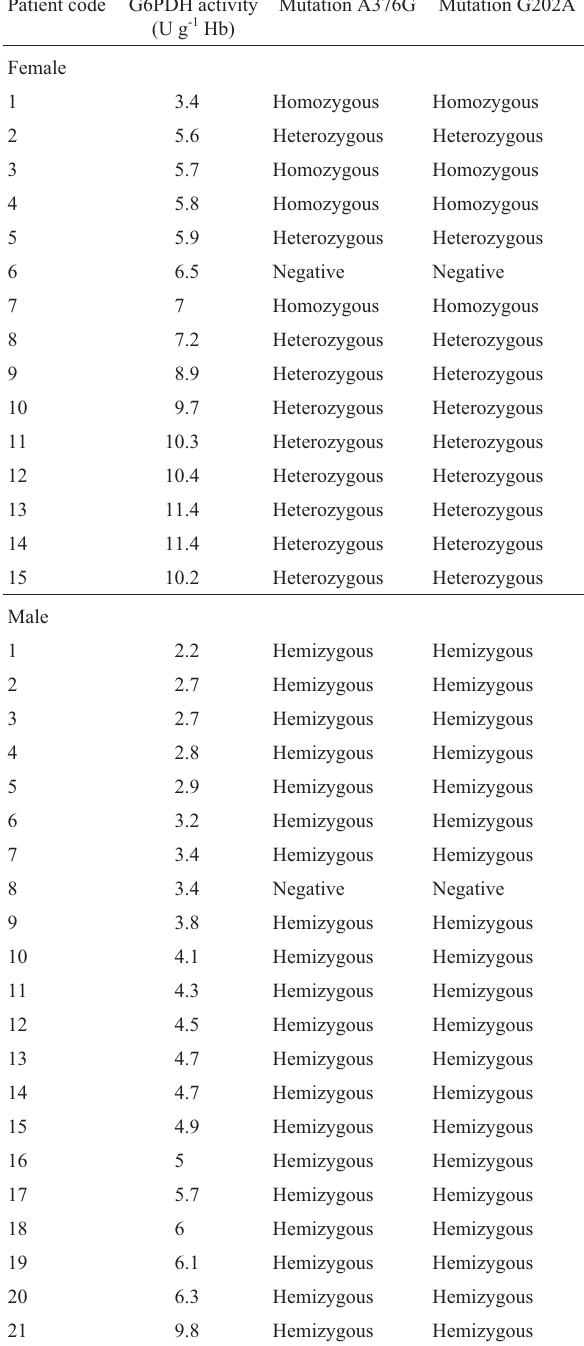
Table 1 - Glucose-6-phosphate dehydrogenase (G6PDH) activity of 15 female and 21 male (n = 36) patients from the southern Brazilian city of Porto Alegre. For both sexes the table is ordered by G6PDH levels, levels lower than 11.5 U g -1 of hemoglobin (Hb) indicate